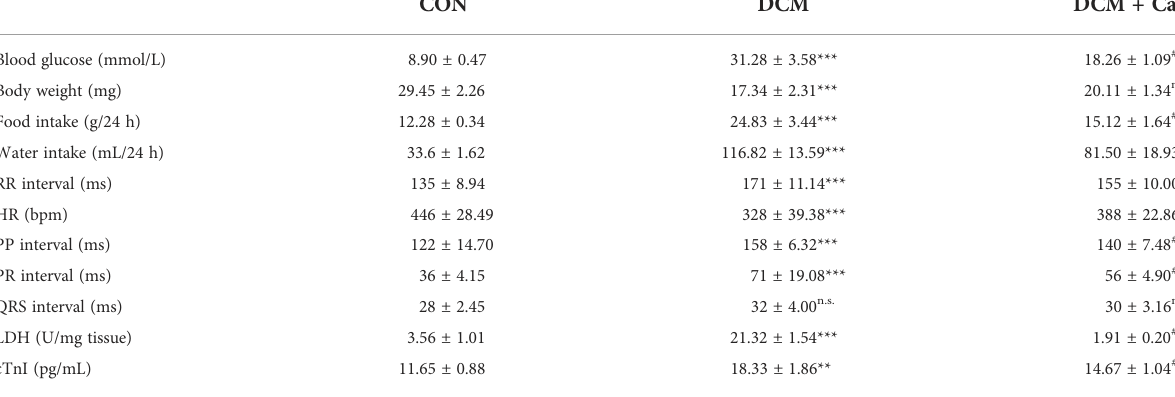
TABLE 3 Basic characteristics of mice in each group at the end of